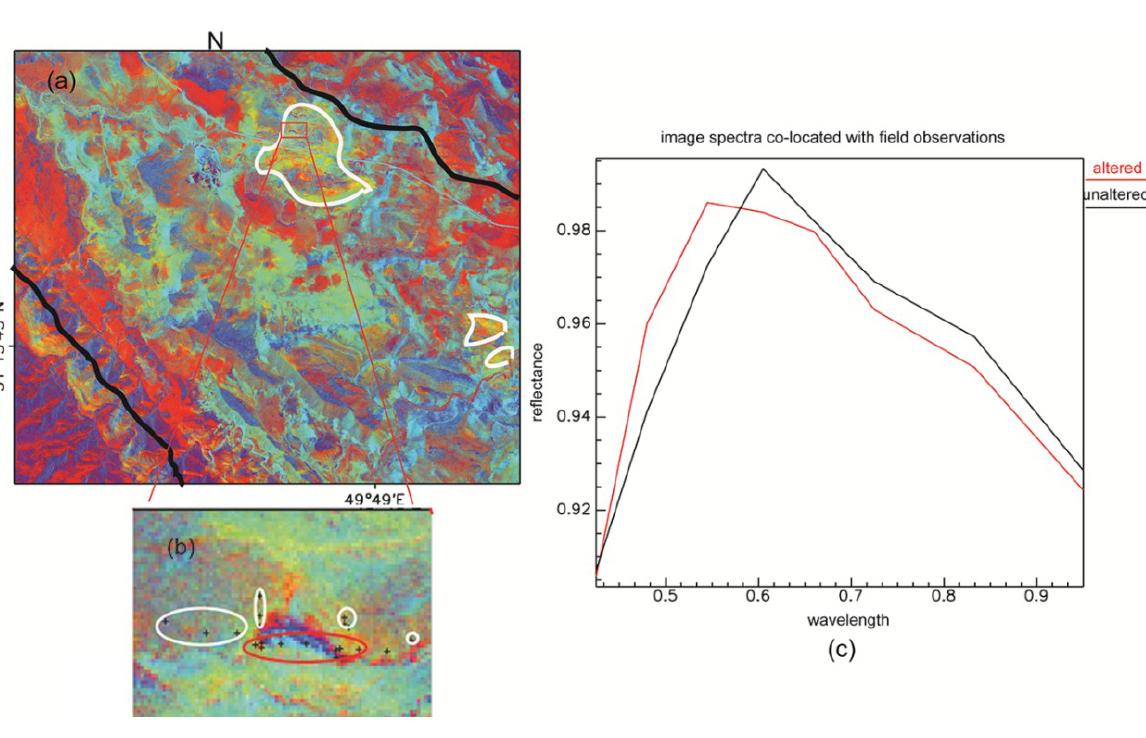
Figure 7. ( a ) Colour composite image (R: 6; G: 3; B: 2) created from WV-2 imagery; ( b ) enlargement showing the location of field measurements. Black crosses indicate